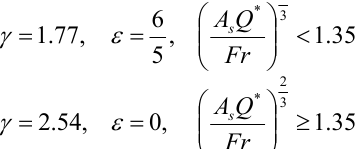
in Eq. (4). k Q * / Fr ) 2/3 as follows: s